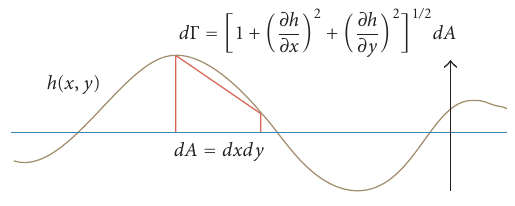
Figure 1: Integration over the imaging